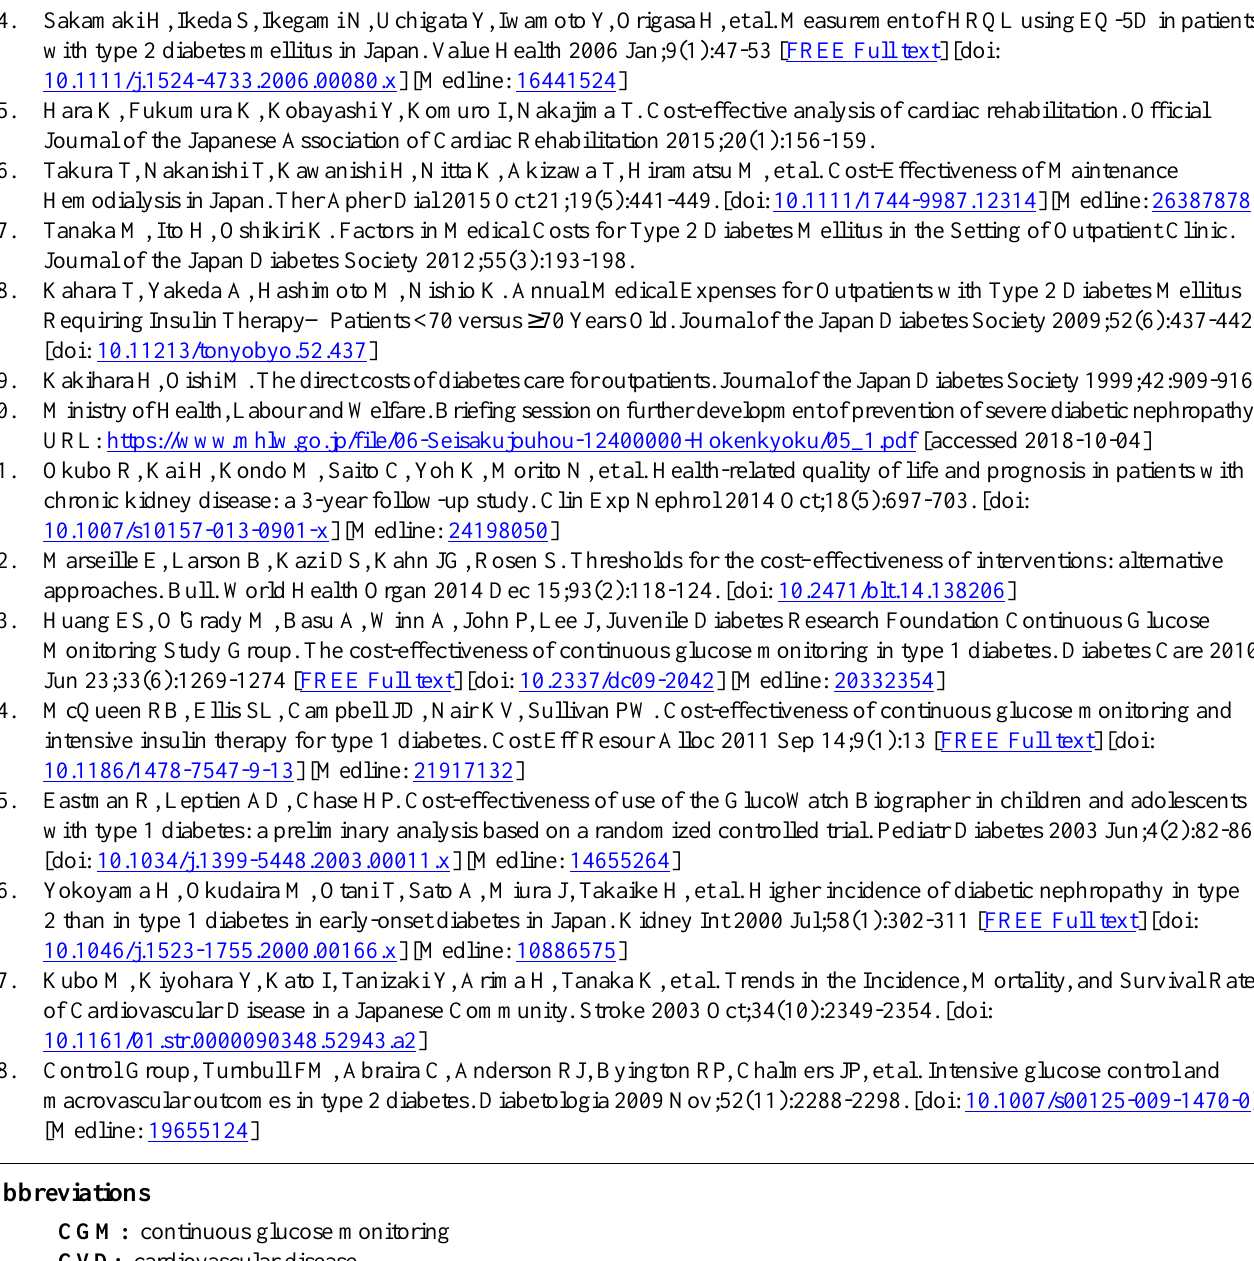
CGM: continuous glucose monitoring CVD: cardiovascular